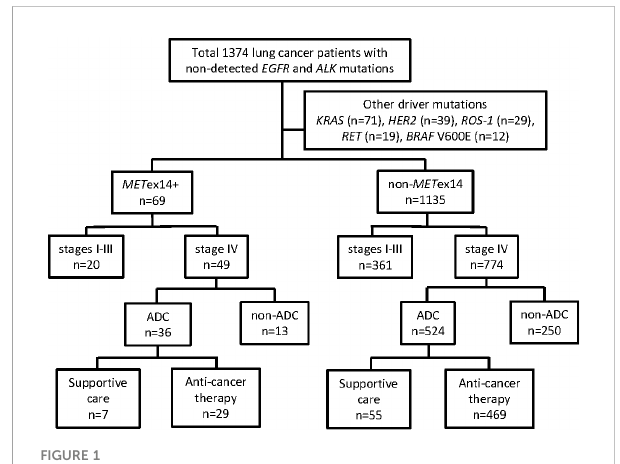
FIGURE 1 Overview of patient selection and patient groups. ADC,